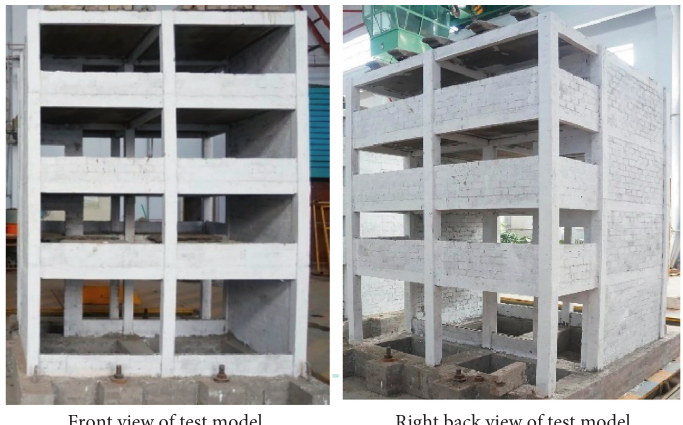
Figure 25: Shaking table test model of RC frame structure.